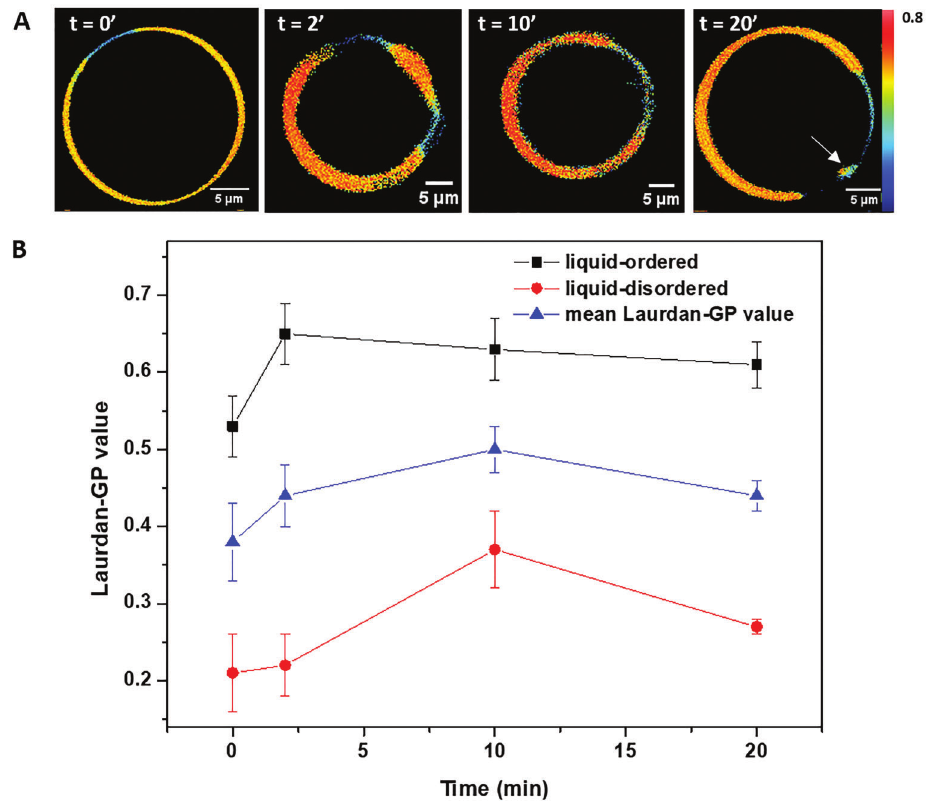
Figure 4. A , Representative generalized polarization (GP) images of giant unilamellar vesicles (GUVs) formed of DOPC/DPPC/ cholesterol (23:47:30 molar ratio), acquired at different times after addition of 100 m M of artepillin C into lipid suspension, at 25°C. The white arrow (t = 20 ’ ) indicates a membrane protrusion occurring in the liquid-disordered region of the membrane. B , Laurdan-GP values versus time from regions of interest (ROIs) corresponding to liquid-ordered (black squares) and liquid-disordered (red circles) phases. The blue triangles correspond to GP values obtained from the whole GUV image, i.e., without ROI